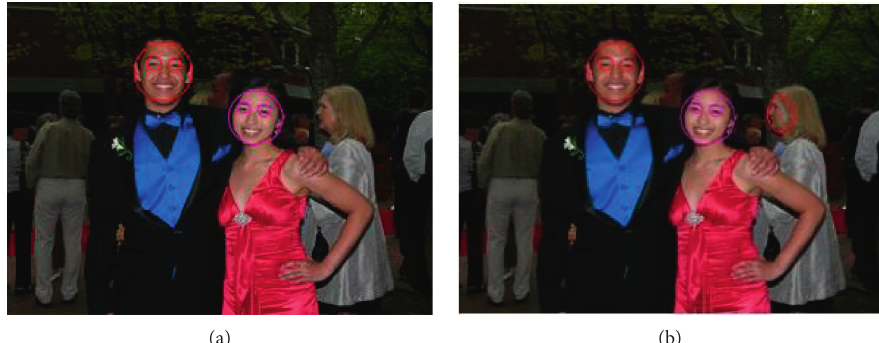
Figure 11: Detection on the original image by the CNN and MSDNN methods. (a) Results by the CNN method. (b) Results by the MSDNN method.